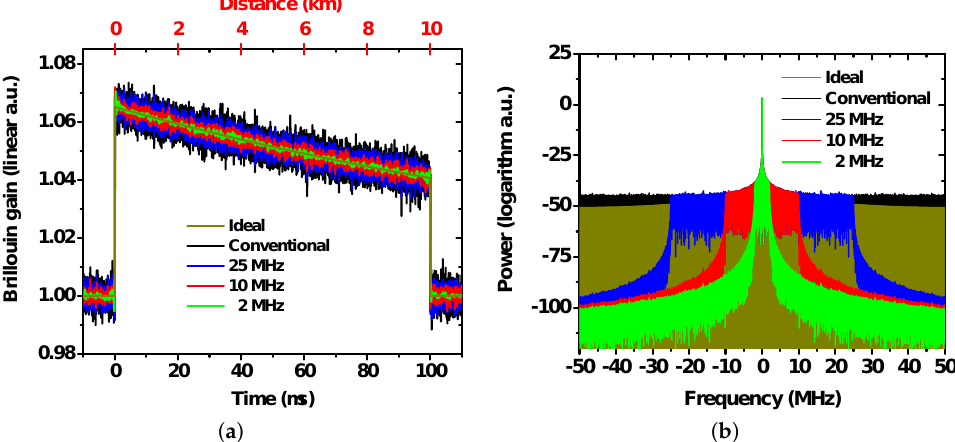
Figure 1. ( a ) Simulated time domain traces of the ideal, conventional and filtered probe signal; ( b ) simulated spectrum of the detected radio frequency (RF) ideal, conventional and filtered probe signal with different filter